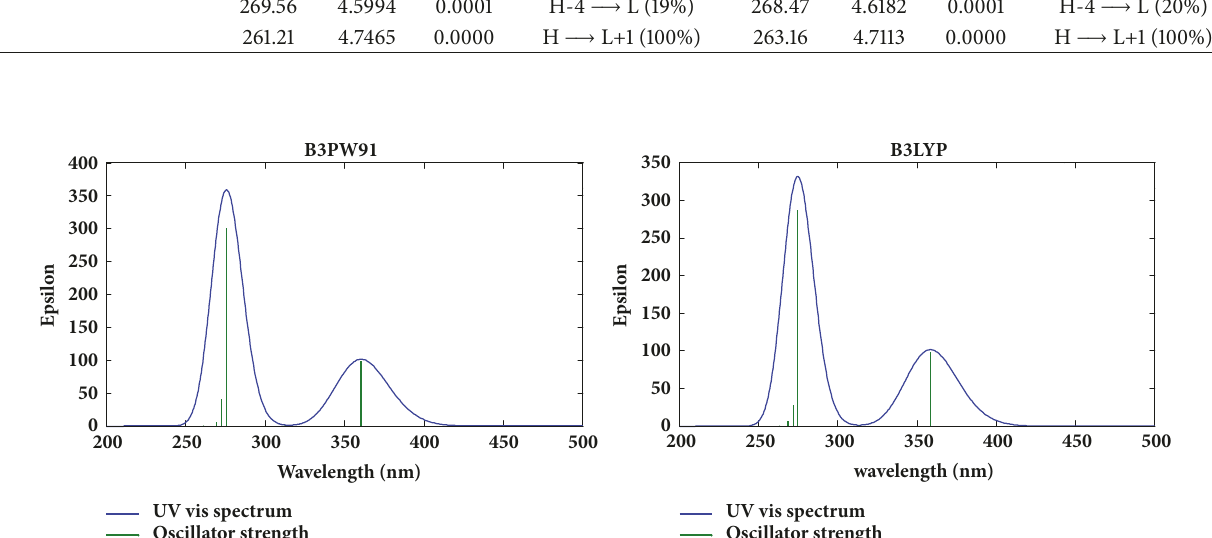
Figure 5: Theoretical absorption spectra of Rubescin E at the B3PW91 and B3LYP levels in gas with the 6-311++G(d,p) basis set.